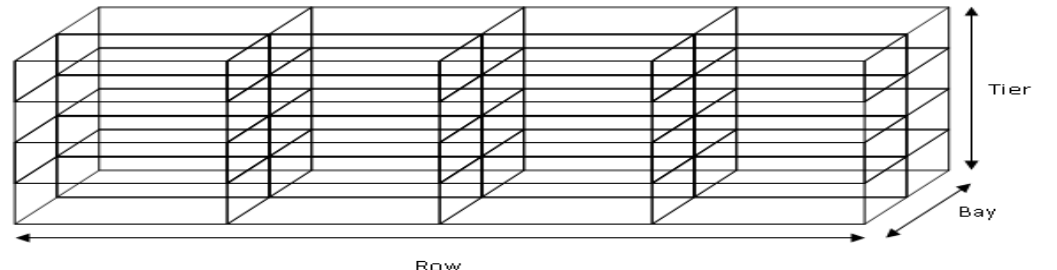
Figure 1. A stacking storage system for containers.